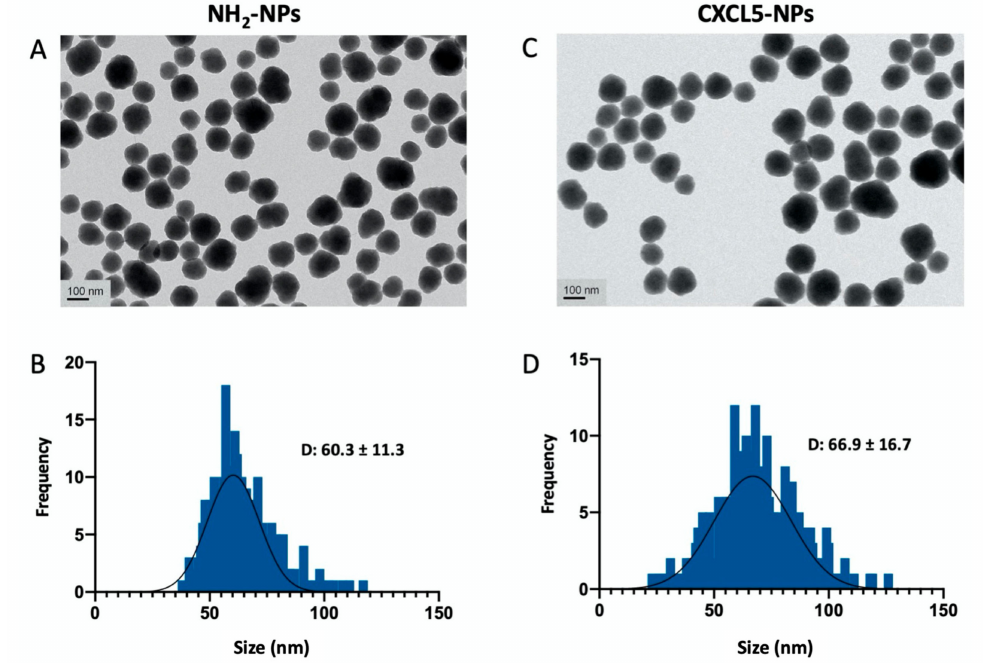
Figure 2. NPs characterization. Transmission electron microscopy (TEM) of NH 2 -NPs ( A ) and CXCL-NPs ( C ). ( B , D ) Histograms of size distribution in nm. D value (diameter) reports the average ± standard deviation (SD) in nm. The particle diameter size distribution was obtained by the measurement of at least 500